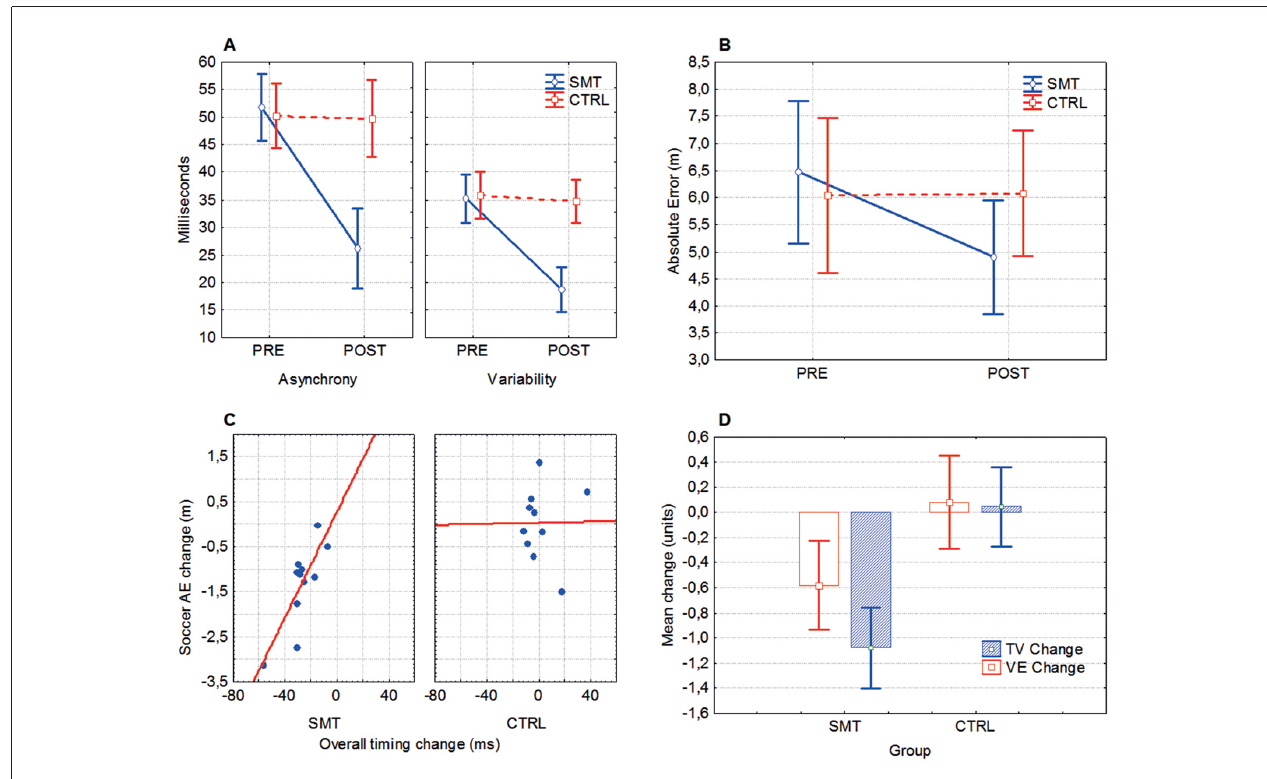
FIGURE 3 | Synchronized metronome training (SMT) and cross-pass outcomes. (A) Mean timing asynchrony (average discrepancy from reference beat) and inter-response variability, in milliseconds. (B) Mean absolute error (AE) denoting the overall distance from the point of impact of the football and the target. (C) Changes in soccer-kick accuracy (AE, absolute error) relative to changes in motor timing performance. In both axes negative numbers denote performance improvement. (D) Pre- to post-test changes in target variability (TV) and variable error (VE). Box, mean + standard error (SE); whiskers, 90% confidence interval. For ANOVA outcomes, vertical bars denote 90% confidence